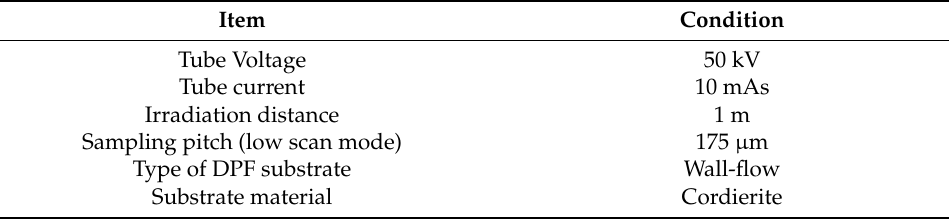
Table 4. The establishment of irradiation conditions.